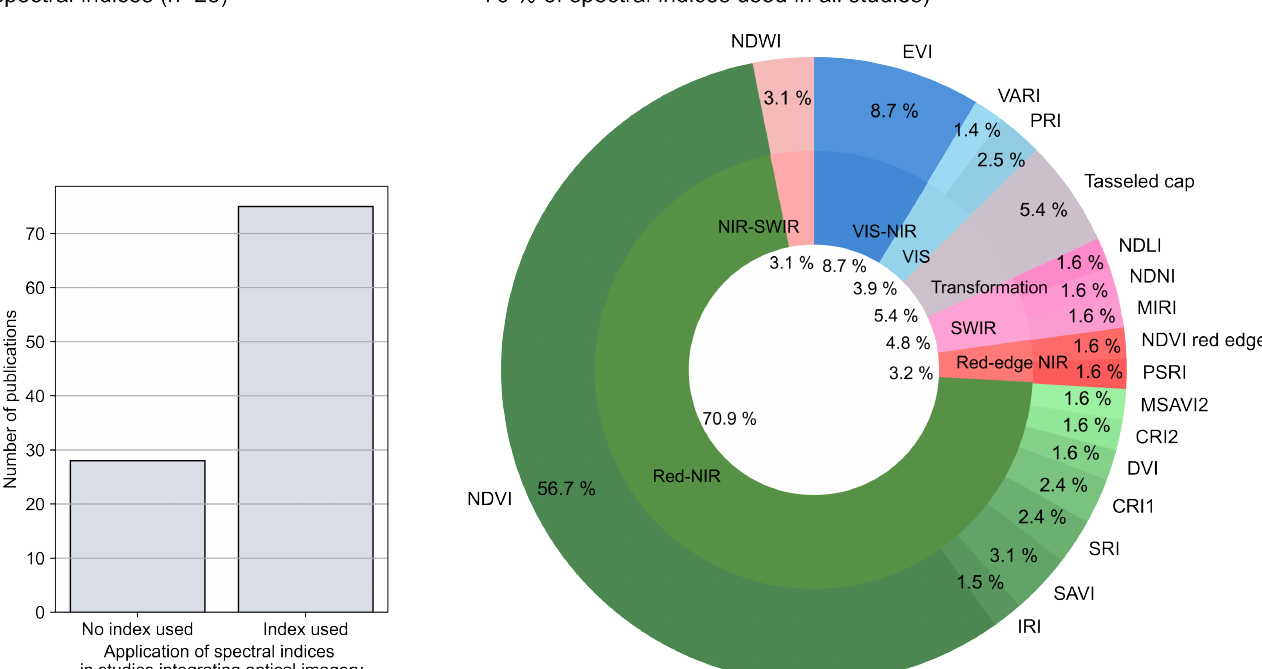
Figure 13. Statistics about calculated spectral indices which were integrated in 75 studies ( a ). Since a large number of different vegetation indices were calculated in all reviewed articles ( n = 58), only spectral indices that were used in more than one reviewed study ( n = 19) are considered in the detailed analysis. The classification of the spectral indices into the different wavelength categories was conducted according to Zeng et al. 2022 [40] ( b ). Abbreviations: CRI1 = Carotenoid Reflectance Index 1, CRI2 = Carotenoid Reflectance Index 2, DVI = Difference Vegetation Index, EVI = Enhanced Vegetation Index, IRI = Infrared Index, MIRI = Mid-Infrared Index, MSAVI2 = Modified Soil Adjusted Vegetation Index 2, NDLI = Normalized Difference Lignin Index, NDNI = Normalized Difference Nitrogen Index, NDVI = Normalized Difference Vegetation Index, NDWI = Normalized Difference Water Index, PRI = Photochemical Reflectance Index, PSRI = Plant Senescence Reflectance Index, SAVI = Soil Adjusted Vegetation Index, SRI = Simple Ratio Index, VARI = Visible Atmospherically Resistant